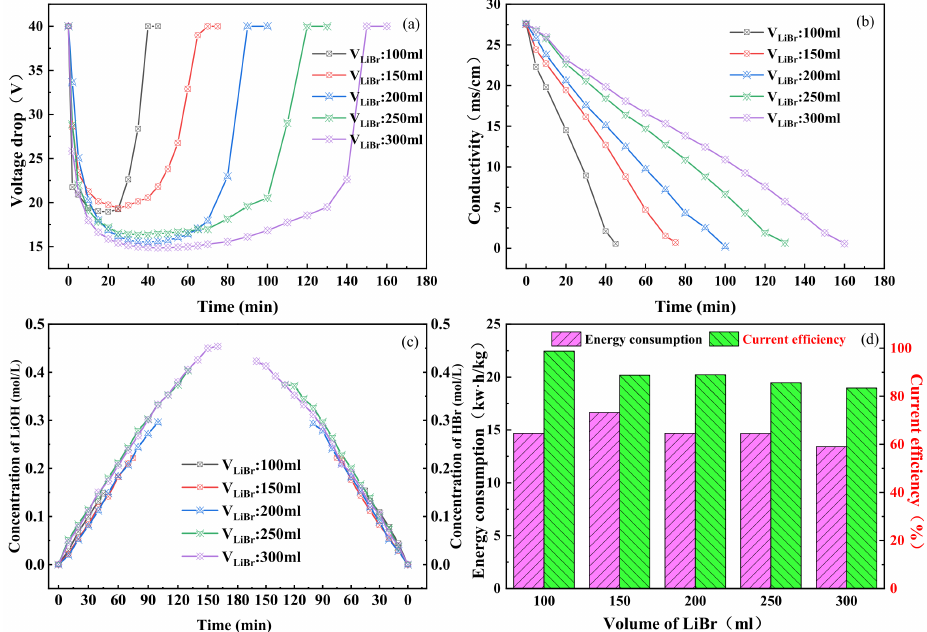
Figure 5. Effect of initial salt chamber volume on BMED performance: ( a ) BMED stack voltage drop; ( b ) the conductivity of the salt chamber; ( c ) hydrobromic acid concentration in the acid chamber and lithium hydroxide concentration in the alkali chamber; ( d ) energy consumption and current efficiency of the whole